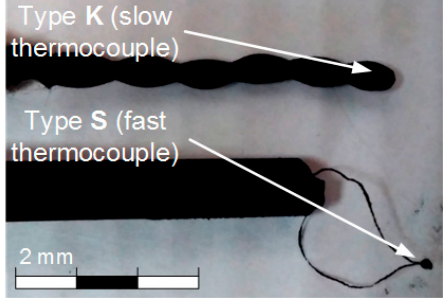
Figure 2. Thermocouples used in the experiments.